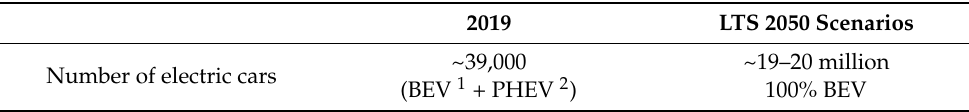
Table 5. Electric cars in Italy in 2019 and the 2050 LTS